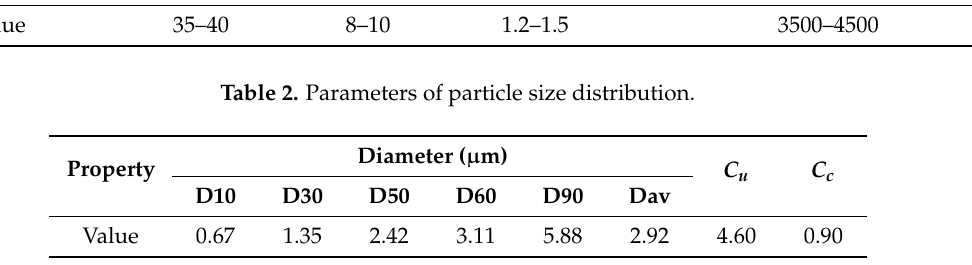
Table 2. Parameters of particle size distribution.